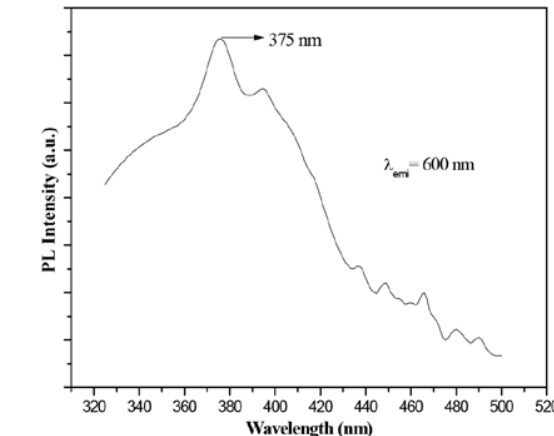
Figure 6. PL emission spectrum (a) and excitation spectrum (b) of nano